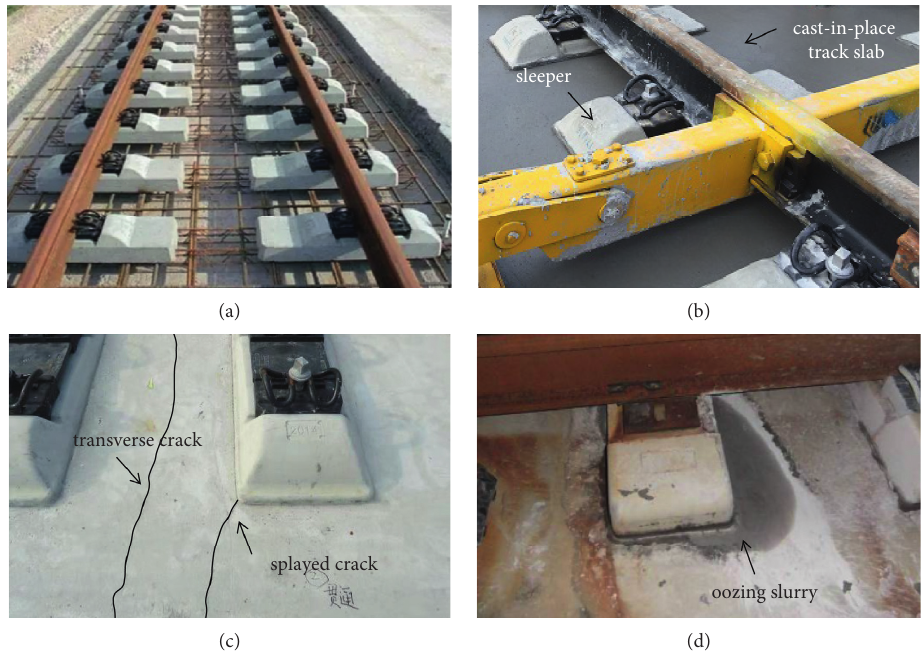
Figure 2: State of bi-block ballastless track at different stages. (a) Accurately adjusted and positioned sleepers [4]. (b) Cast-in-place track slab. (c) Early cracks. (d) Oozing slurry.